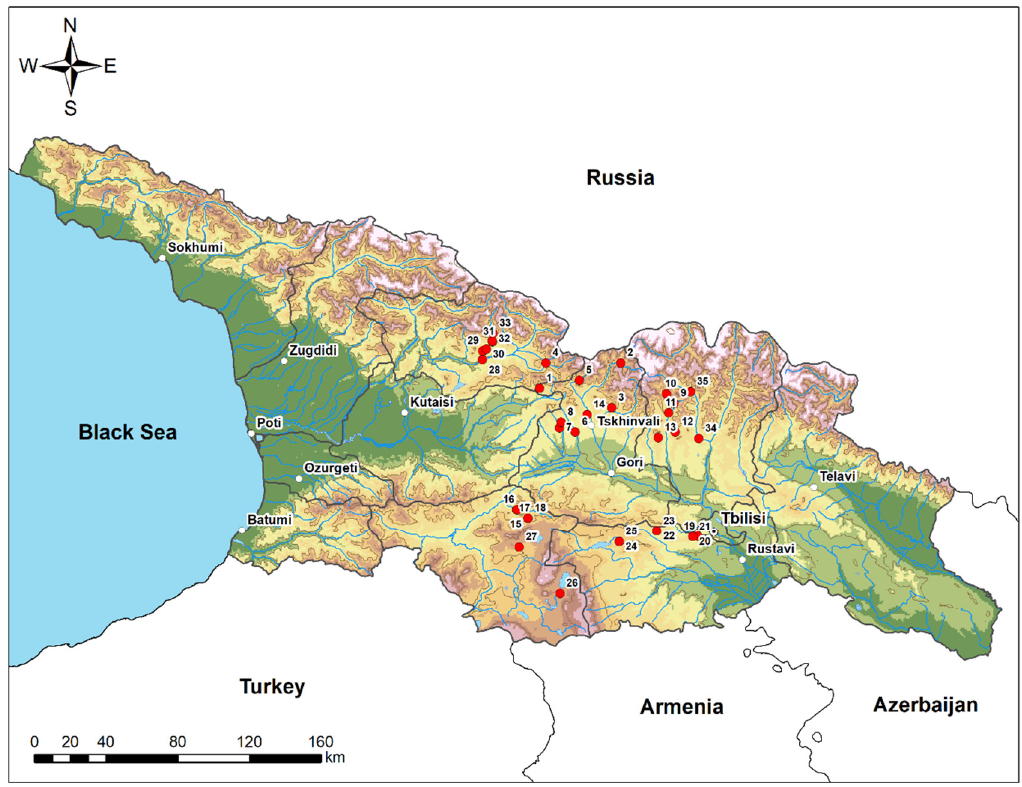
Figure 1. Sampling Figure 1. Sampling map.